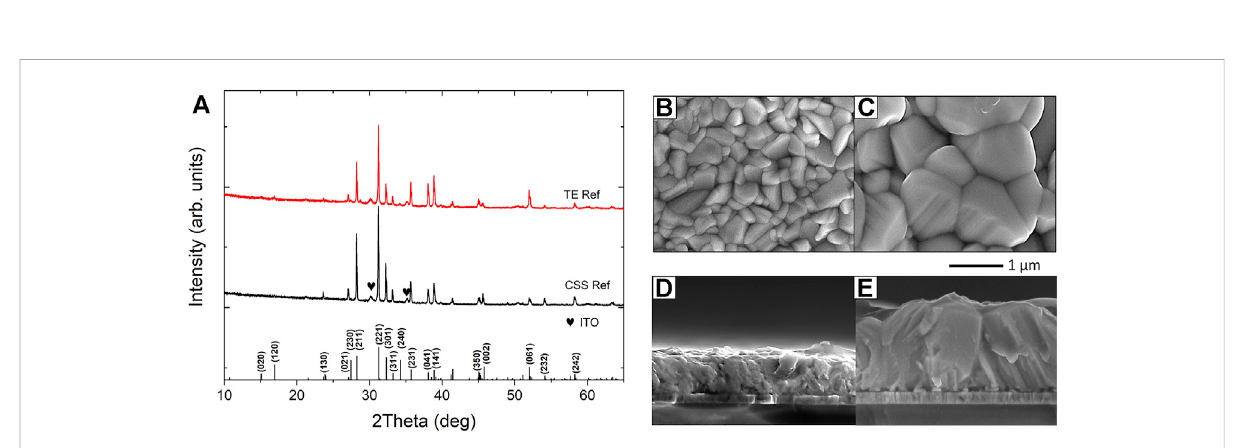
FIGURE 7 (A) XRDpatternsofSb 2 Se 3 layersdepositedbyTEandCSSonITO/CdSsuperstrateswithstandarddiffractionpatternforSb 2 Se 3 (JCPDS15-0861) included for reference and SEM images of corresponding TE (B,D) and CSS (C,E) Sb 2 Se 3